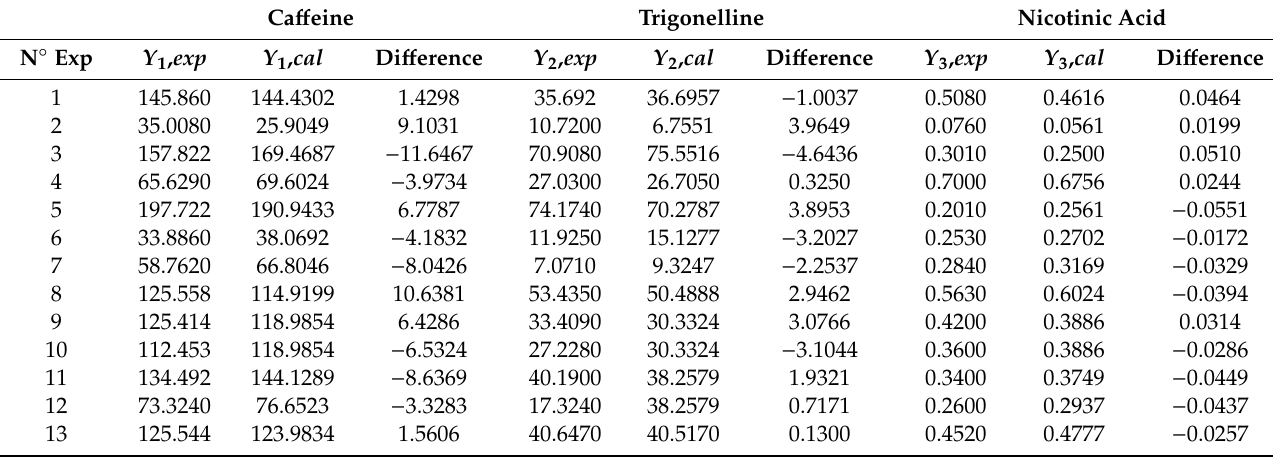
Table 6. Experimental values ( Yi,exp ), predicted values ( Yi,cal ) for the contents of ca ff eine ( Y 1 ), Trigonelline ( Y 2 ), and Nicotinic acid ( Y 3 ), along with the model residuals. Ca ff eine